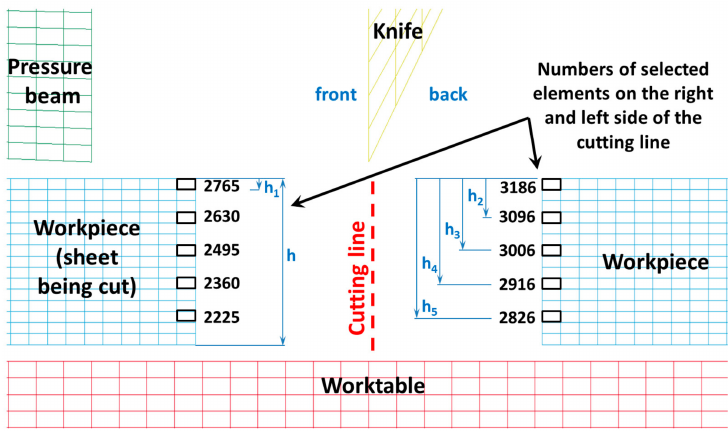
Figure 11. Sheet with selected marked numbers of finite elements accordingly in front of the cutting tool (on the left of the cutting line) and in the back of the cutting tool (on the right of the cutting